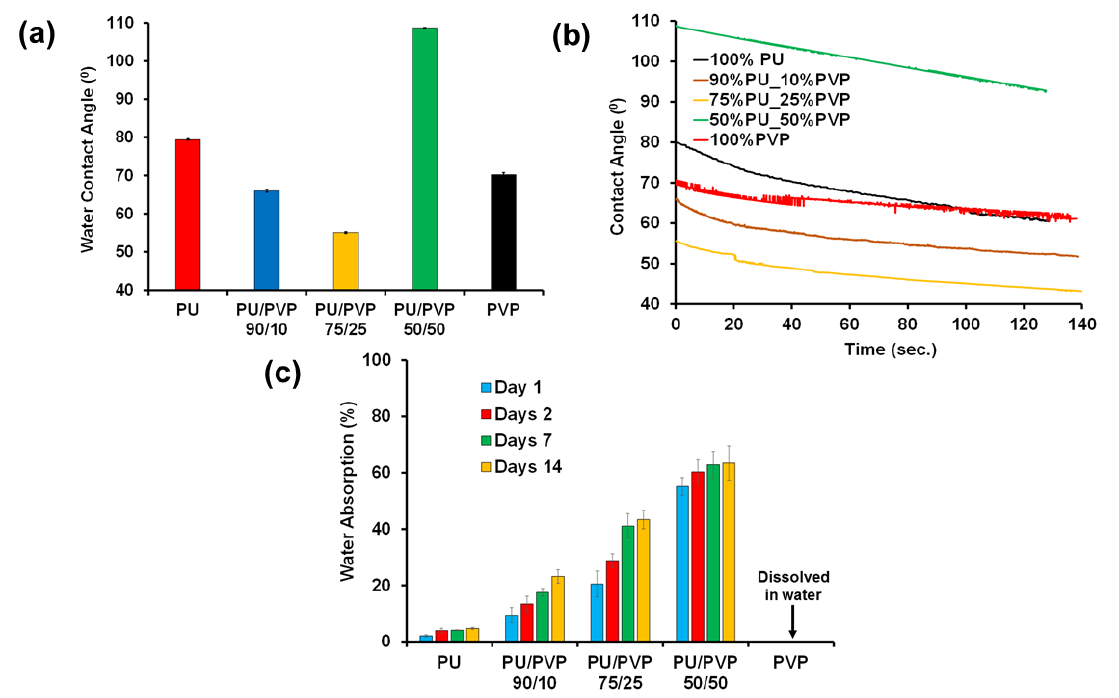
Figure 6. ( a ) Static water contact angle, ( b ) dynamic water contact angle, and ( c ) percent water absorption data of pure polymers and the hybrid films.